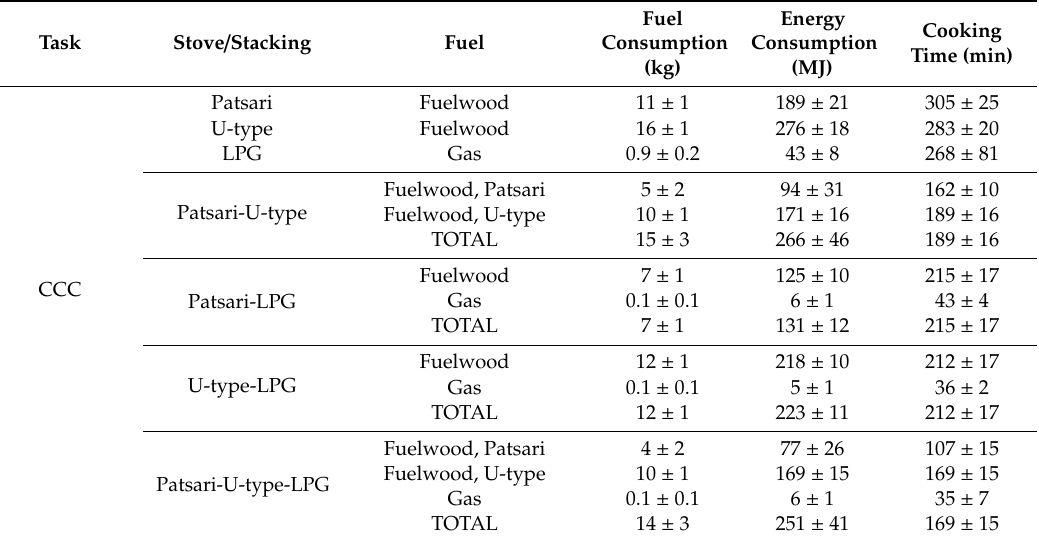
Table 3. Fuel, time, and energy consumption for CCC.